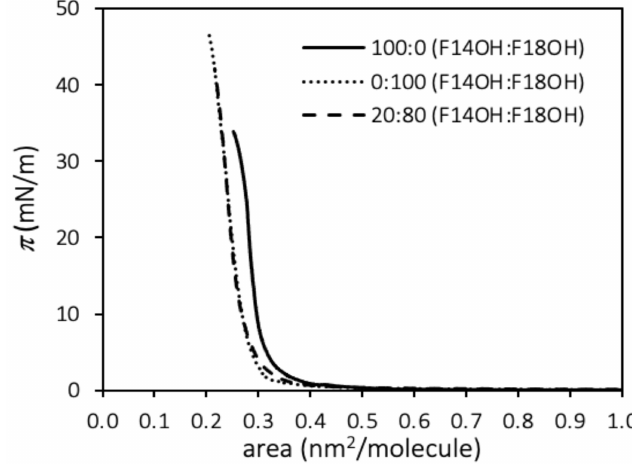
Figure 1. Surface pressure—molecular area ( π – A ) compression isotherms at 20 ◦ C for monolayers of F14OH, F18OH and a 20:80 molar mixture of the two